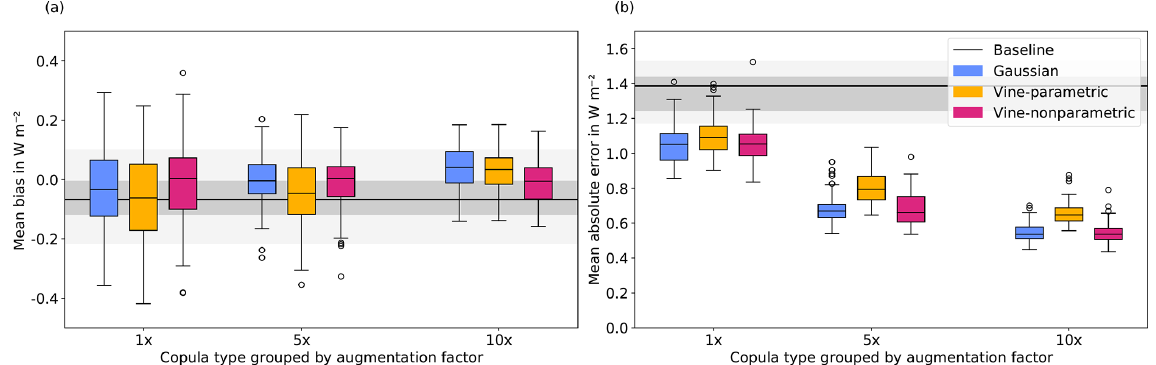
Figure 5. Errors grouped by different copula types (Gaussian: blue, vine-parametric: yellow, vine-nonparametric: red) and augmentation factors (1 × , 5 × , 10 × ) for the mean bias (MB; a ) and mean absolute error (MAE; b ). The median for the baseline case is shown in black, and the range is shaded in grey.